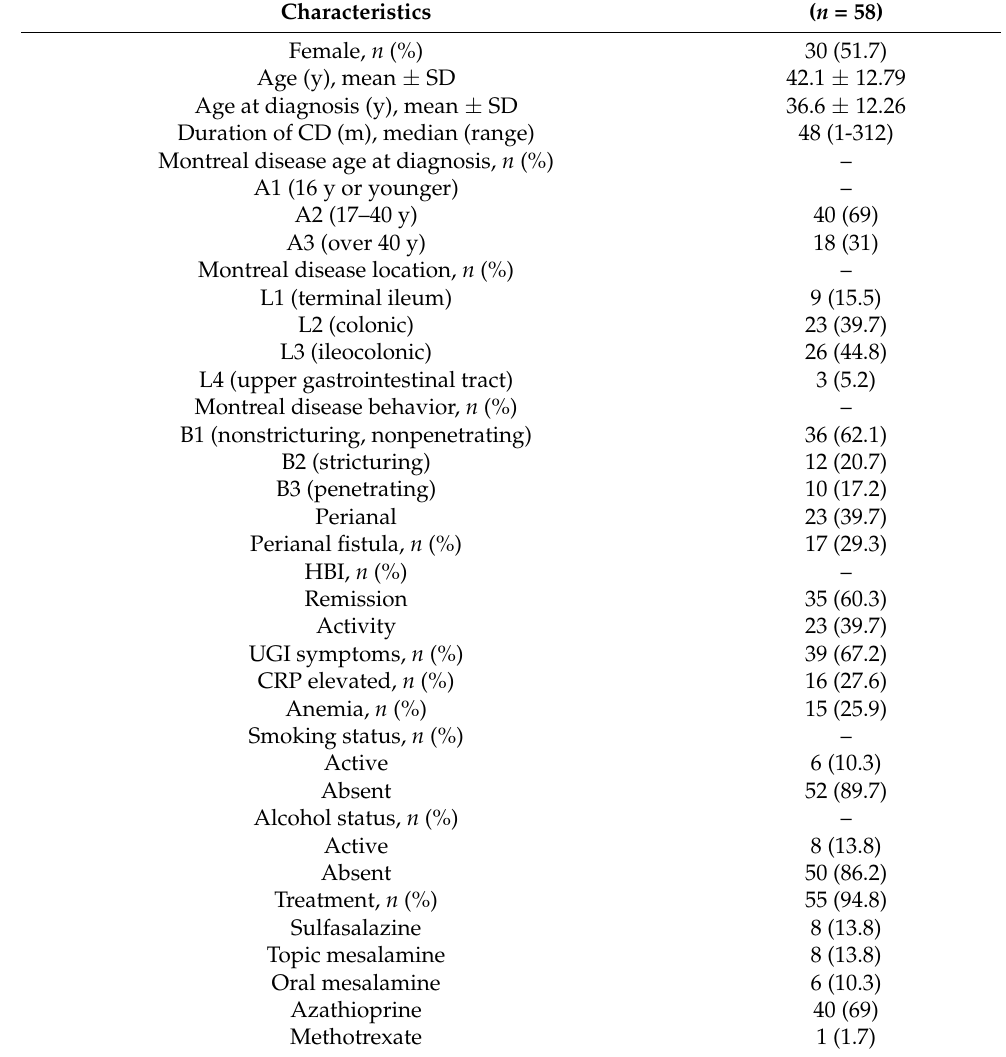
Table 1. Clinical and Demographic Characteristics of Patients with CD from Salvador/BA.